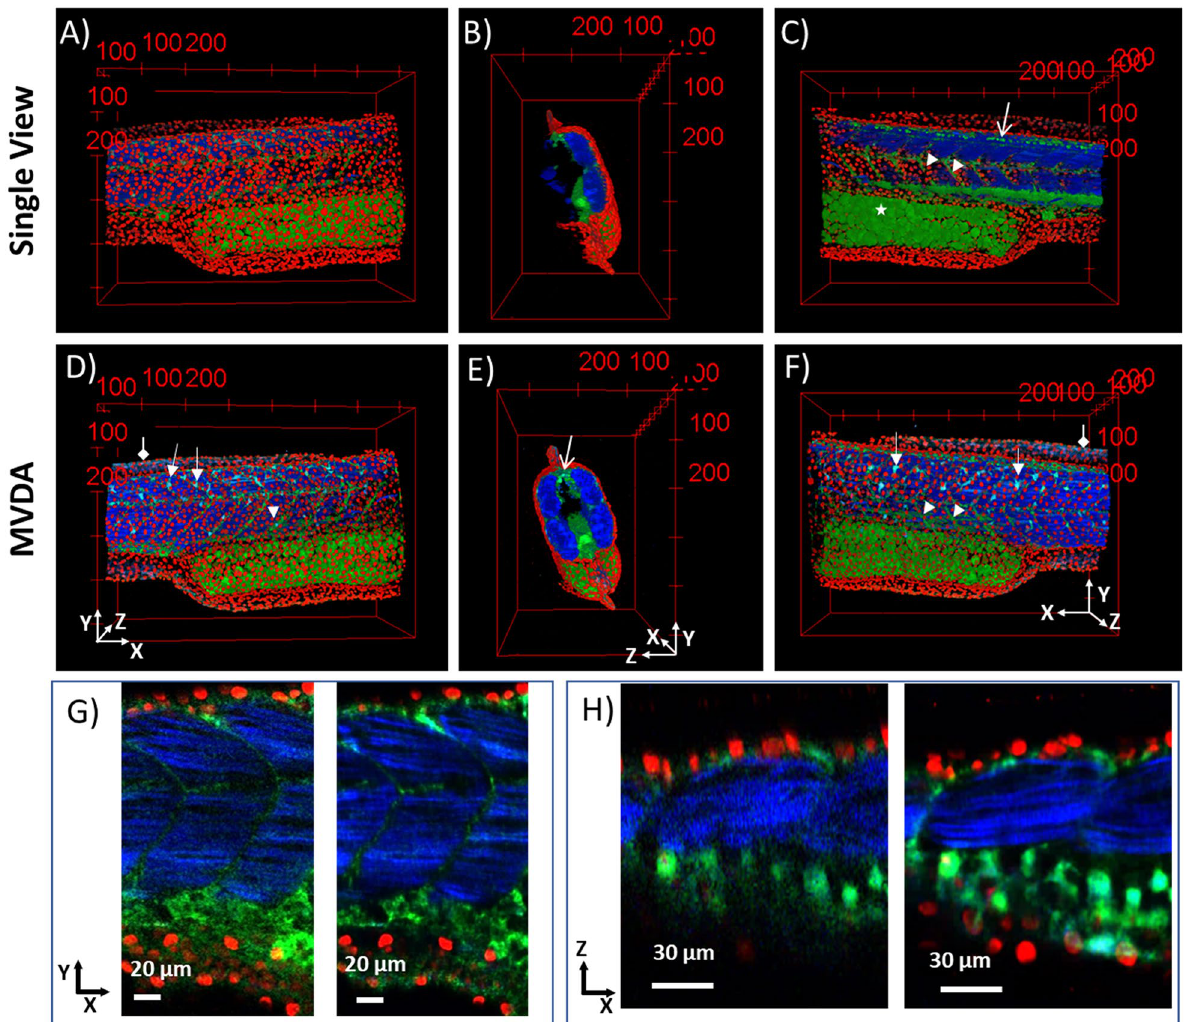
Figure 4. 3D images of SV and MVDA. Nuclei in red, autofluorescence and sensory neurons (GFP) in green, muscle fibres and collagen in blue. ( A ) SV image, ( B ) SV image rotated 90° to the right. ( C ) SV rotated 180° compared to ( A ). ( D ) MVDA image with the same viewing perspective as A). MVDA image rotated 90° to the right compared to ( D ). ( F ) MVDA rotated 180° compared to ( D ). Arrow heads: myotomes, Diamond arrows collagen in the fins, Open arrows: sensory neurons, Arrows: dendritic like cells. ( G ) 2D images in the XY plane of SV left and MVDA right. ( H ) 2D images in the XZ plane of SV left and MVDA right. (Images were created with Fiji 26